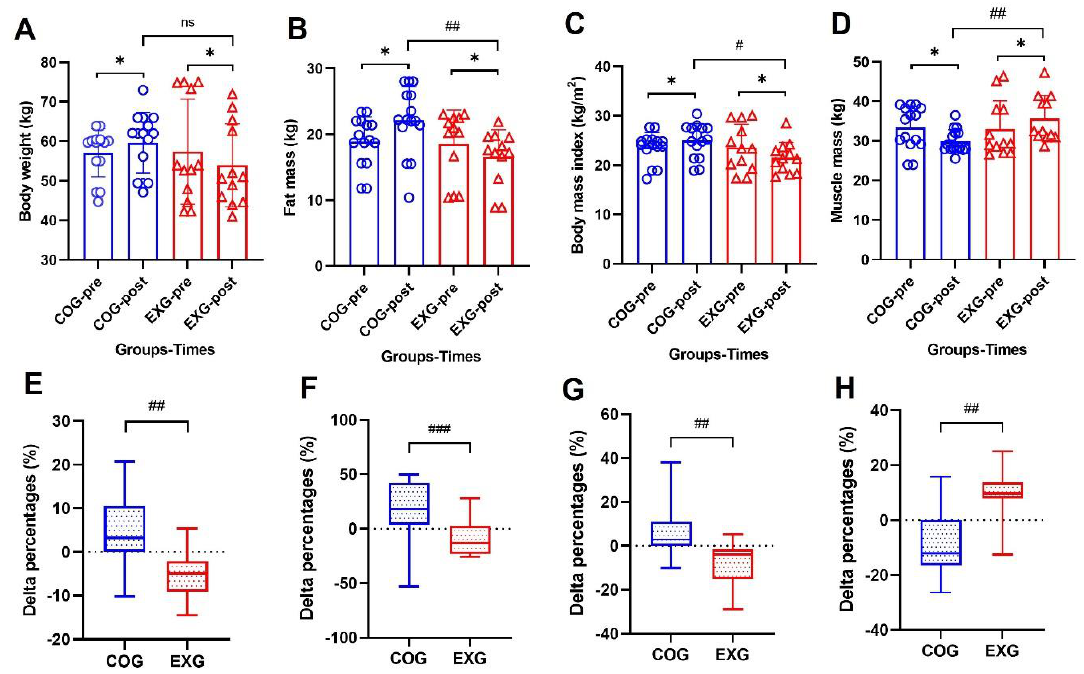
Figure 4. Body composition is improved in the ovarian cancer survivors after 12 weeks of aerobic and resistance exercise. ( A ) Body weight in the control group (COG) and in the exercise group (EXG). ( B ) Fat mass in the COG and EXG. ( C ) Body mass index in the COG and EXG. ( D ) Muscle mass in the COG and EXG. ( E ) Percentages of body weight analyzed as ∆ % in both groups. ( F ) Percentages of fat mass analyzed as ∆ % in both groups. ( G ) Percentages of body mass index analyzed as ∆ % in both groups. All data are represented as means ± SD. p -values were calculated by Student’s t test or